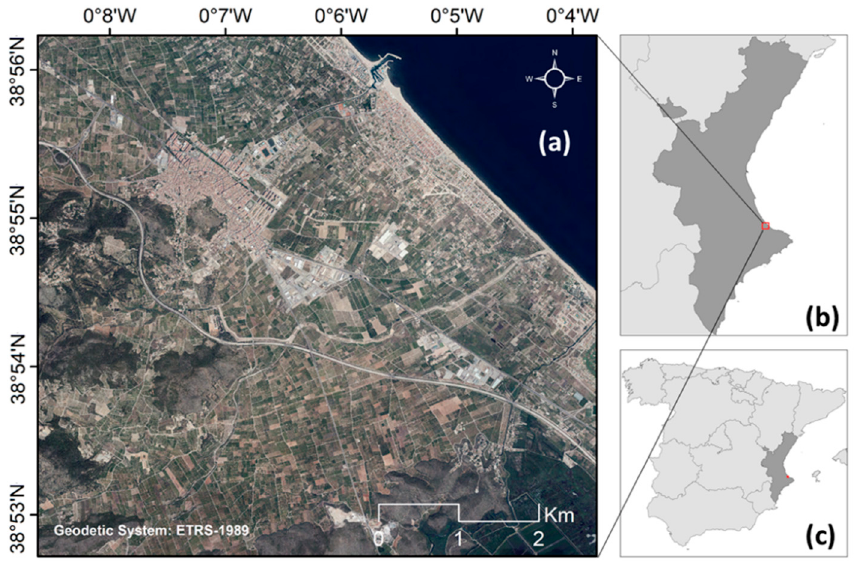
Figure 1. Location of the study area ( a ) in the Valencian Region ( b ), Spain ( c ).